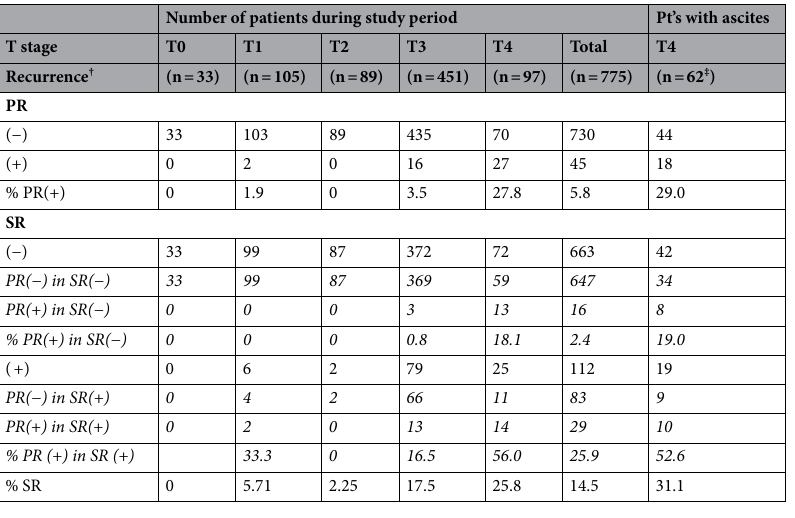
Table 3. Peritoneal and systemic recurrence rates * during study period according to T stages in curatively resected patients. *Recurrence of patients excluding palliative resection, preoperative chemo- or radiotherapy, retroperitoneal rectal cancer, M1c stage, operative mortality and follow up less than 1 month regardless of ascites harvest. † PR: peritoneal recurrence; SR: systemic recurrence. ‡ One patient with ascites but without IL10 data was included.